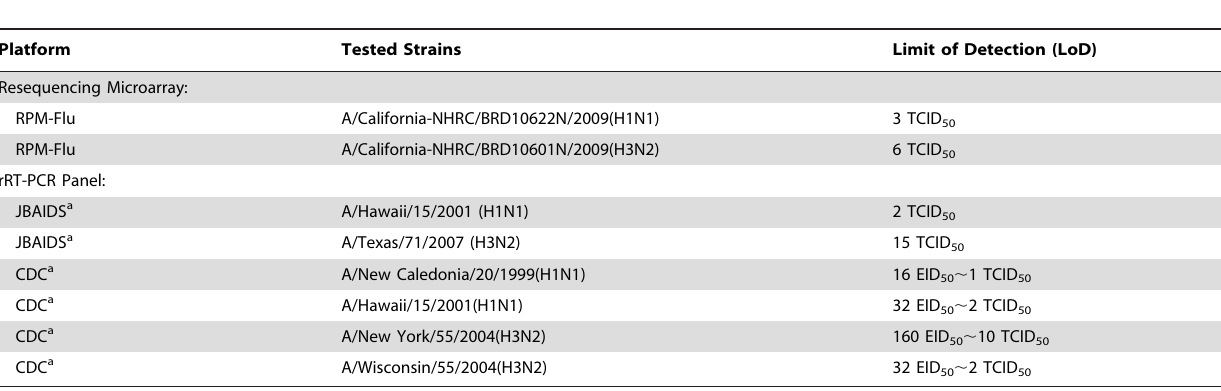
Table 7. Similar analytical sensitivity for seasonal influenza virus detection using RPM-Flu and rRT-PCR panel assays.